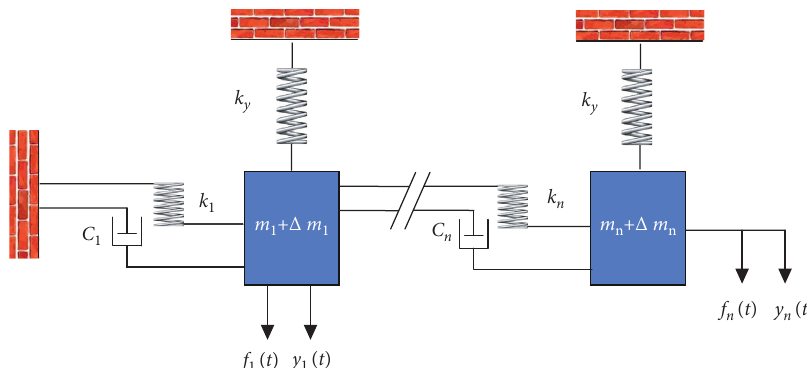
Figure 4: The theoretical model of the vertical vibration of deployable solar arrays with multiple